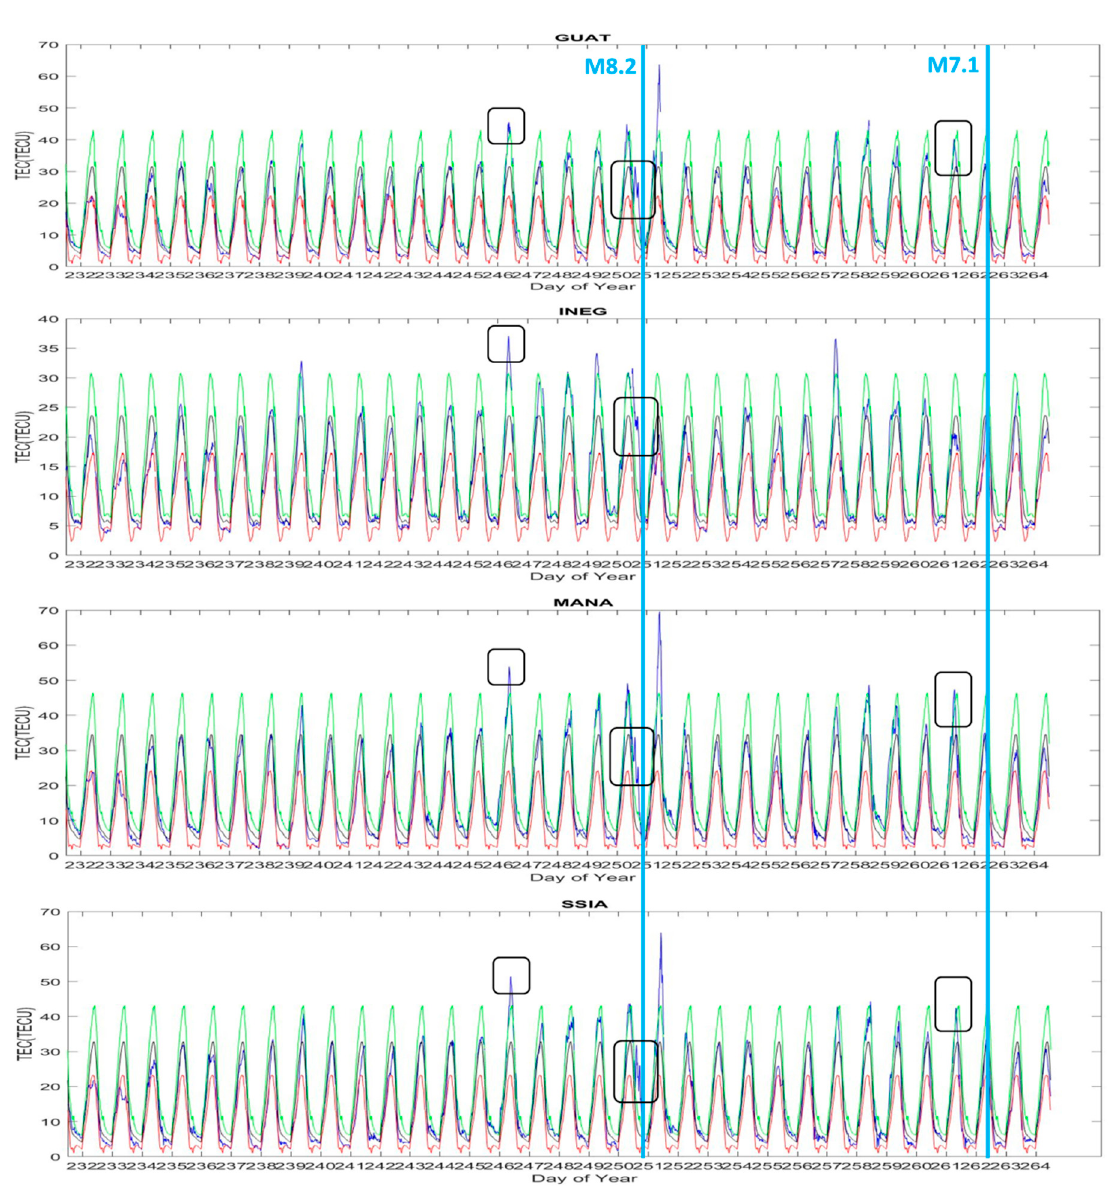
Figure 2. Daily TEC variations (blue solid line) along with its upper (green solid line) and lower bounds (red dotted line) fixed at µ ± 1.34 σ and mean TEC variations µ (black solid line) are depicted for 4 GPS stations for 33 days ( from 20 August to 21 September 2017). Blue vertical lines show the occurrence of 8.2 Mw and 7.1 Mw earthquake on 8 September (251 day of year) and 19 September (262 day of year) respectively. The marked areas with black boxes show positive TEC anomalies on 3 and 8 September (Day of year 246 and 251 respectively).